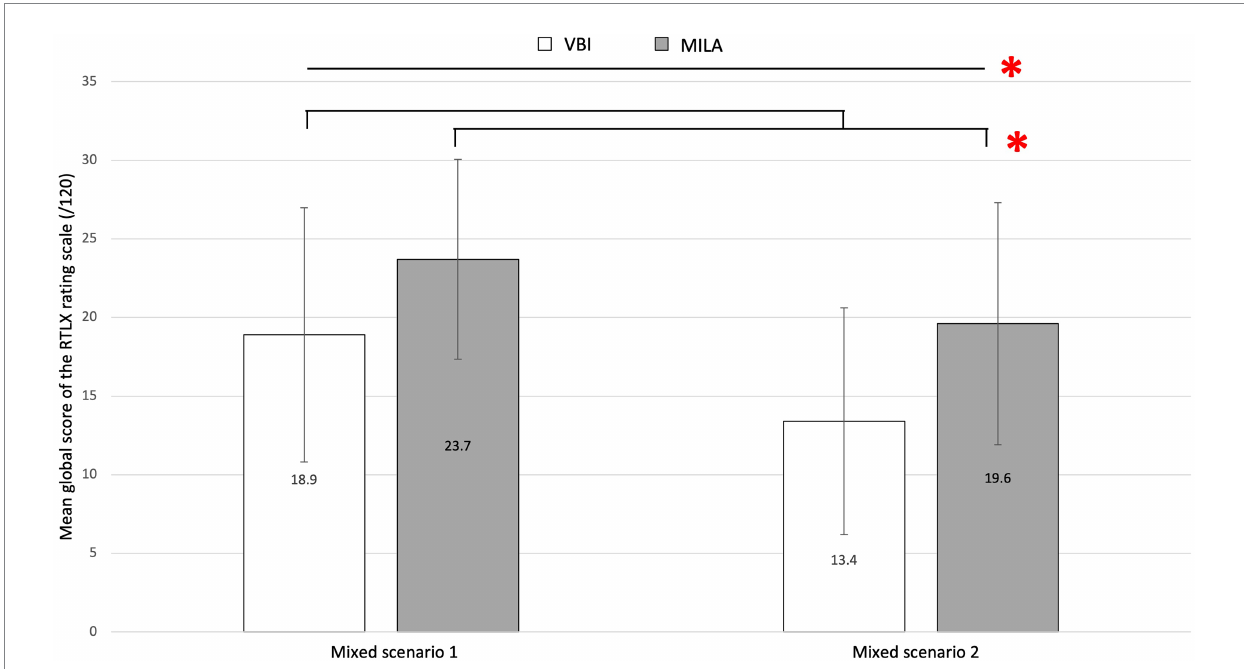
FIGURE 6 Graphic representation of the mean global RTLX scores, depending on the interface and the driving scenario. Error bars represent the standard deviations. *Significant difference ( p <